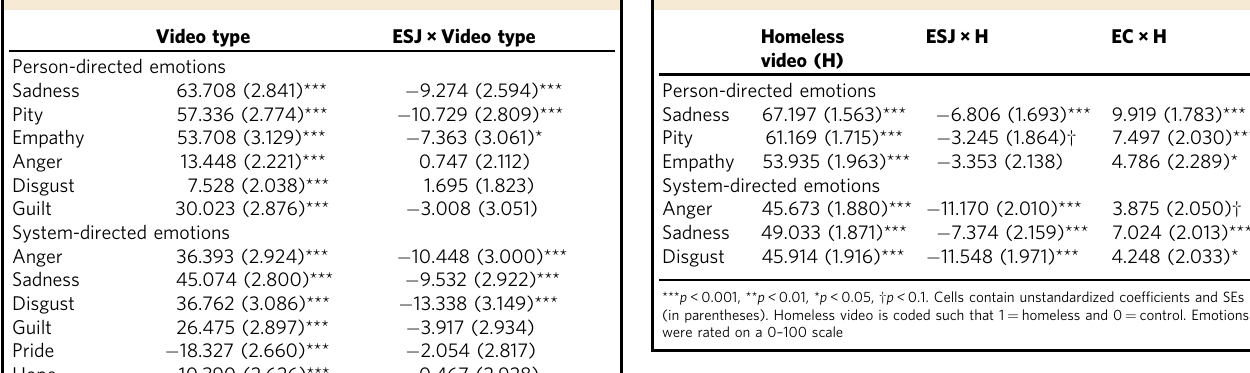
Table 2 Person- and system-directed emotions as a function of economic system justi fi cation (ESJ), empathic concern (EC), and exposure to the homeless videos in Study